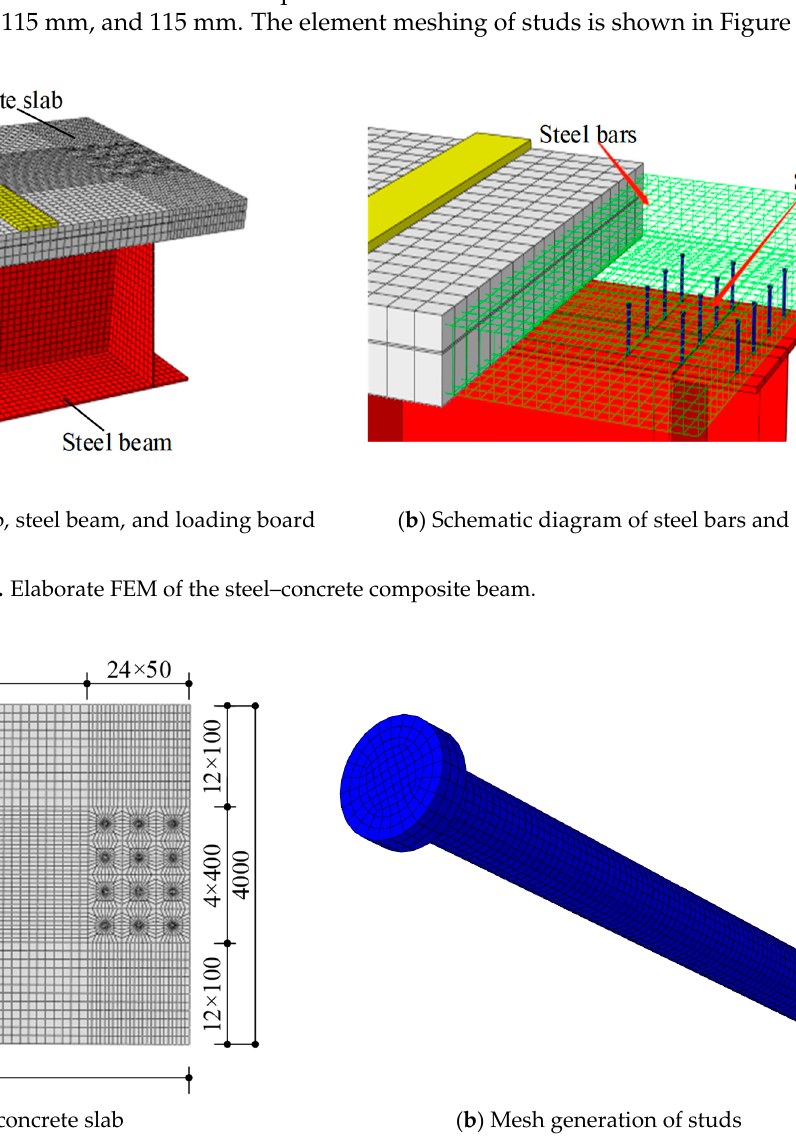
Figure 4. Elaborate mesh generation of the critical parts.